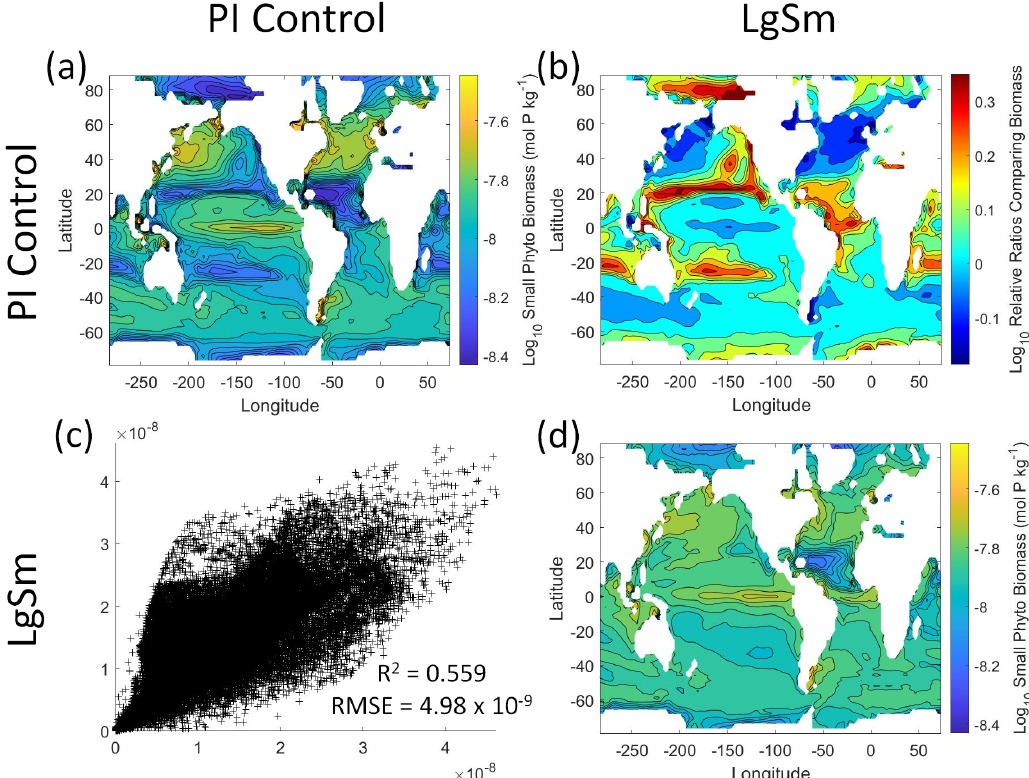
Figure 9. Comparison of the model runs for small phytoplankton biomass in Case 2. The units for biomass in all panels are molPkg − 1 . The panels show point-by-point scatter plots comparing the model runs against one another (c) , yearly averaged log 10 biomass plots for each model run (a, d) , and the log 10 relative ratios comparing the yearly averaged contour plots of the model runs (b) . The x axis and y axis of the scatter plots (c) correspond to the horizonal and vertical model run labels, respectively (e.g., panel c shows PI Control on the x axis and LgSm on the y axis). The yearly averaged log 10 contour plots (a, d) correspond to the matching horizontal and vertical model run labels (e.g., panel a shows the yearly averaged log 10 biomass of PI Control). The log 10 relative ratios (b) were calculated as the model run listed on the horizontal axis divided by the model run listed on the vertical axis (e.g., panel b shows LgSm divided PI